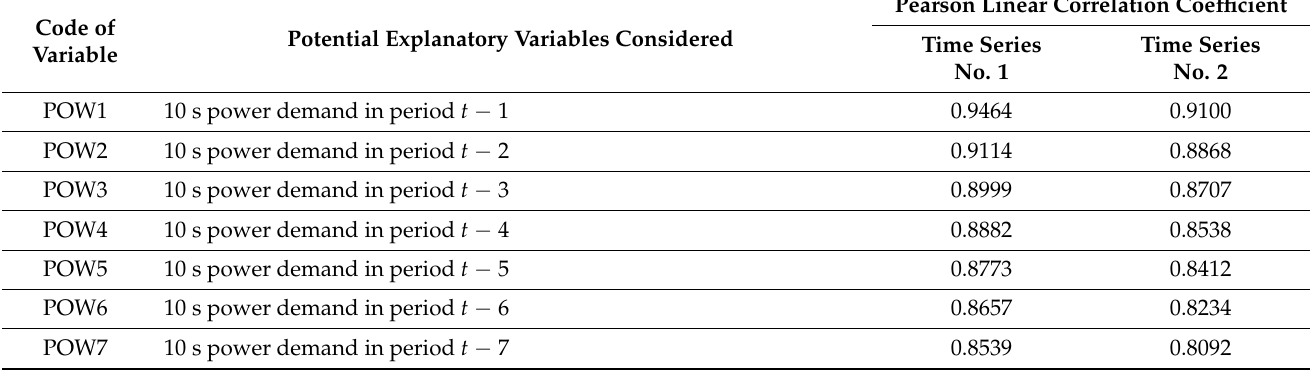
Table 2. Values of Pearson linear correlation coefficients between 10-second power demand of the first time series and the second time series and the explanatory variables considered (partially based on [44]).